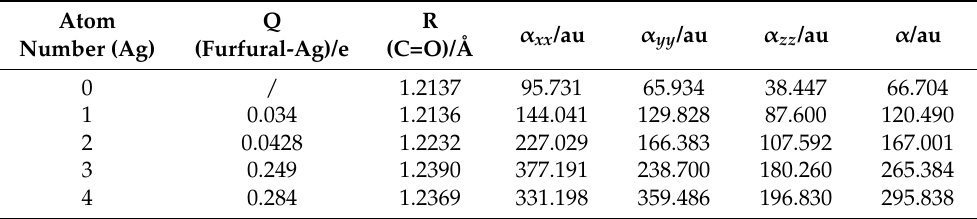
Table 2. The charge transfer, bond length (C=O) and polarizability of furfural-Ag x ( α xx , α yy , α zz represent the polarizability of three axes respectively; α represents the polarizability of furfural